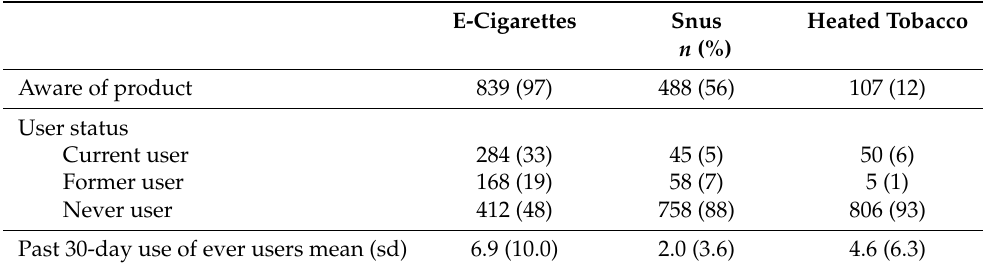
Table 3. Awareness and use of potentially modified risk tobacco products ( n =